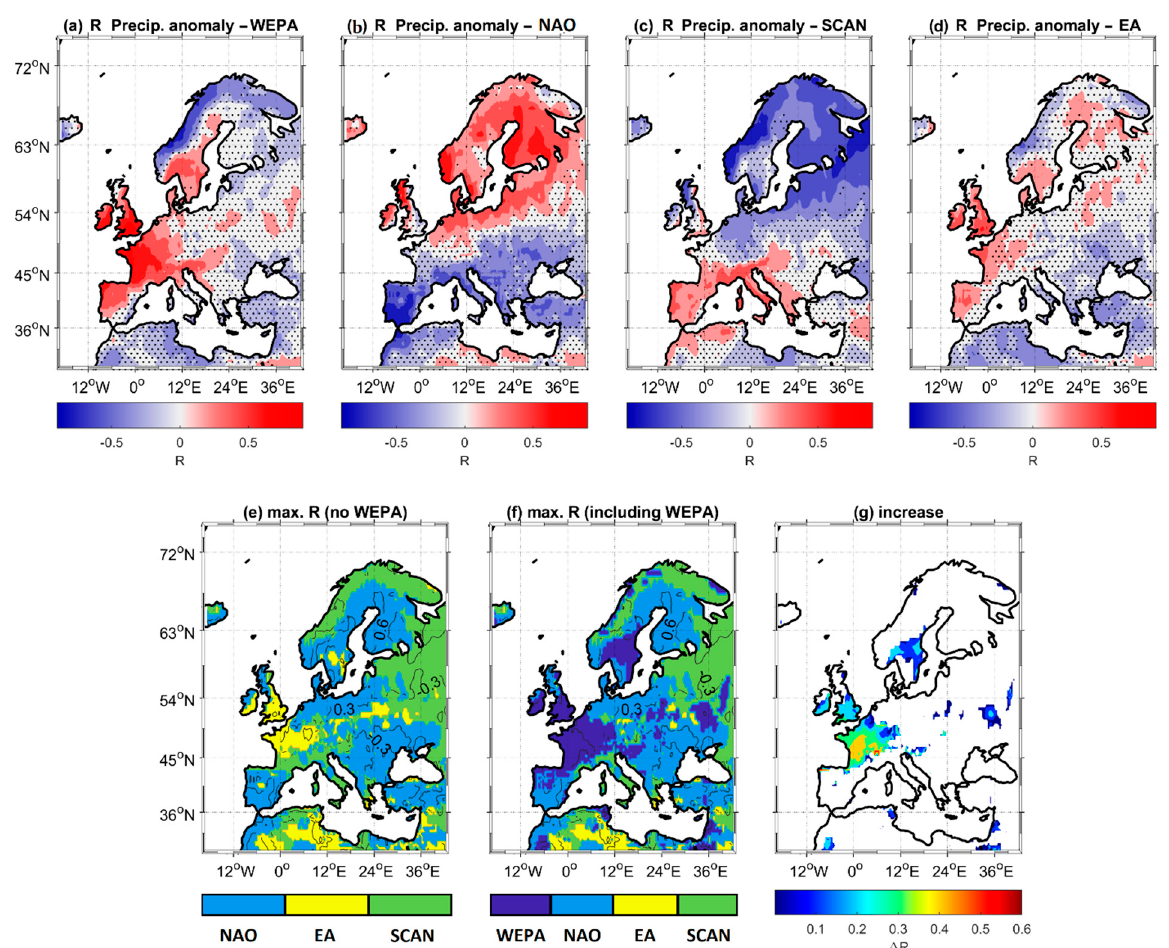
Figure 4. ( a – d ) Spatial correlation of winter-averaged (DJFM) precipitation anomaly with winter-averaged ( a ) WEPA, ( b ) NAO, ( c ) SCAN, and ( d ) EA. Dotted areas show statistically insignificant values ( p = 0.05). ( e – g ) Spatial distribution of the climate indices that best explain the variability of local winter precipitation ( e ) ignoring and ( f ) including WEPA, with contours of the corresponding correlation coefficient R. ( g ) Corresponding spatial distribution of the increase ( ∆ R) in R between ( e ) and ( f ).